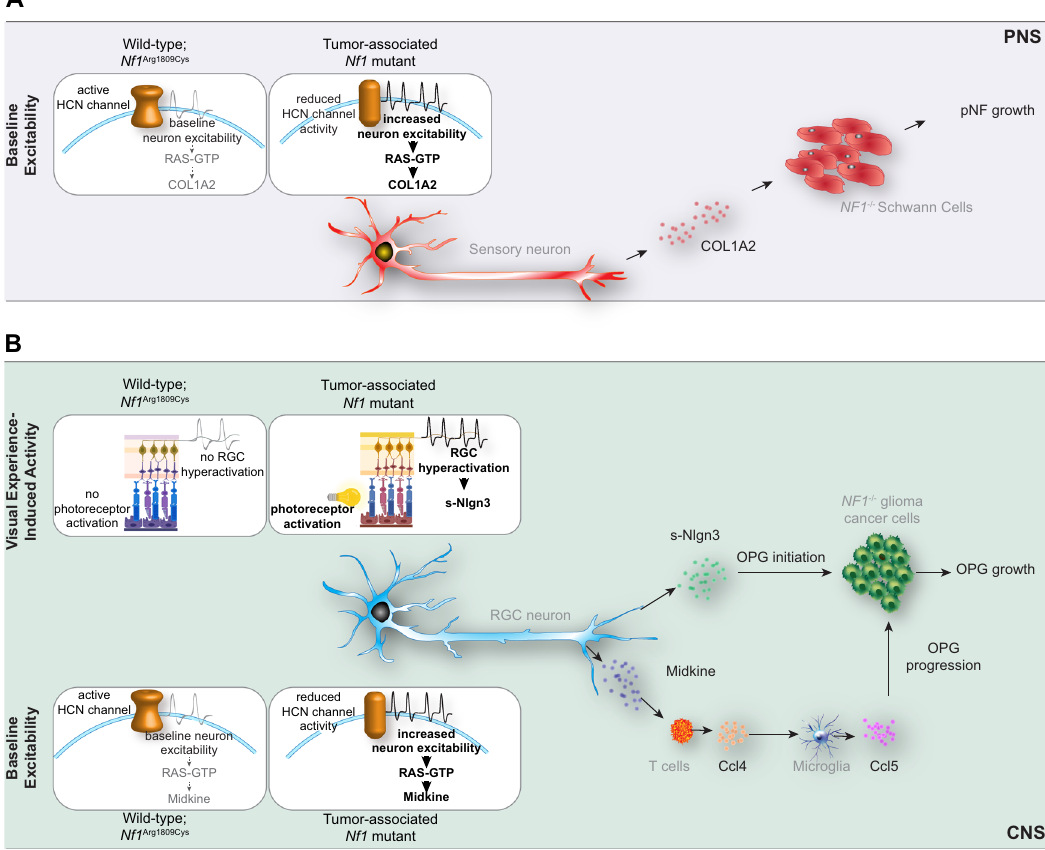
Fig. 8 Proposed model for NF1 mutation-induced, neuronal hyperexcitability-regulated low-grade tumor growth. A Tumor-associated NF1 -mutant sensory neurons have increased baseline neuron excitability and deregulated HCN channel function, leading to elevated COL1A2 secretion. COL1A2, in turn, increases NF1 − / − Schwann cell proliferation to stimulate pNF growth. B Tumor-associated NF1- mutant retinal ganglion cell (RGC) activity is governed by two distinct mechanisms. First, visual experience (light)-induced activity enhances RGC production of soluble-Nlgn3 (s-Nlgn3), which drives OPG initiation and cell growth. Second, tumor-associated NF1- mutant RGCs have increased intrinsic baseline neuronal hyperexcitability, which is controlled by HCN channel function. Increased baseline HCN channel-regulated RGC excitability triggers increased midkine production to induce a T-cell (Ccl4) and microglial (Ccl5) signaling cascade that governs OPG progression and growth. PNS, peripheral nervous system, CNS, central nervous system, pNF, plexiform neuro fi broma, OPG, optic pathway glioma. Small elements of this schematic were designed on BioRender.com. Source data are provided as a Source Data fi